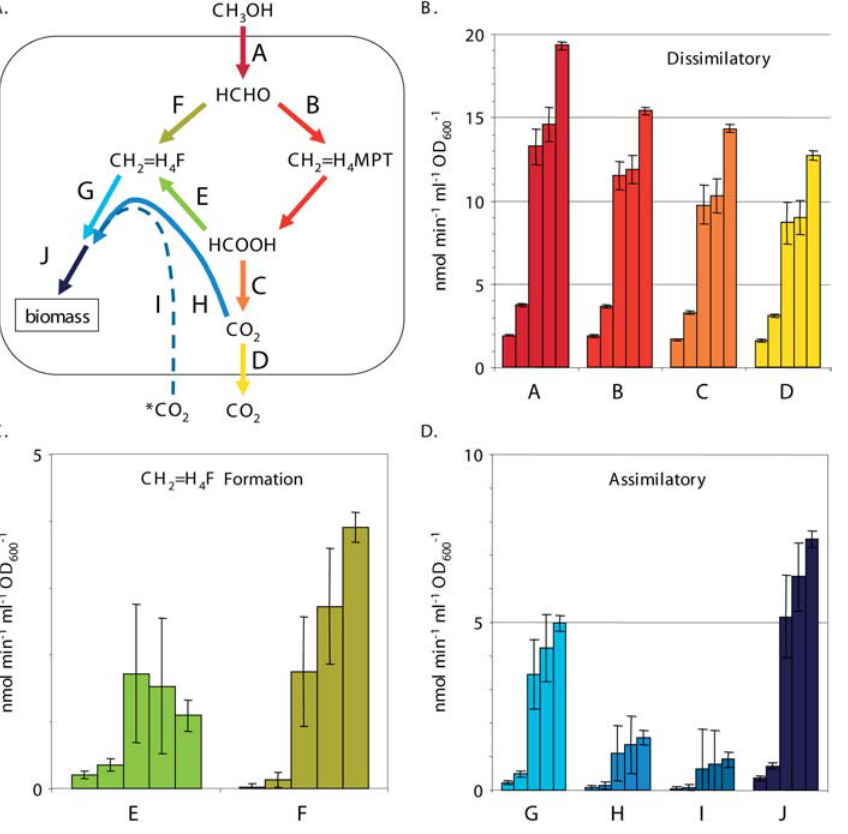
Figure 4. C 1 Fluxes during Transition from Succinate to Methanol The fluxes determined are represented schematically (A). The other panels present flux for each branch, labeled A through J. The five bars for each flux represent a time series from cells harvested 1 h prior to the transition from succinate to methanol, and 1, 5, 7.5, and 10 h after the switch. Dissimilatory (B), methylene-H 4 F formation (C), and assimilatory (D) fluxes are presented separately with different scales for clarity. Flux F represents maximum fluxes. DOI: